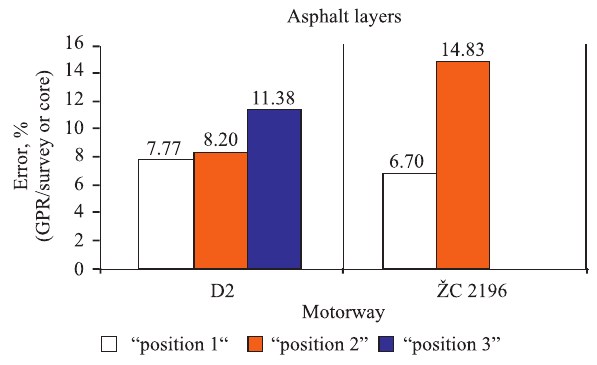
Fig. 7. Comparison to the thickness of asphalt layers on